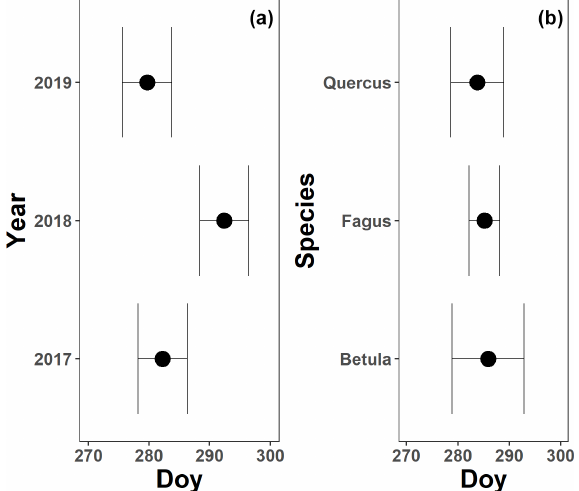
Figure A4. The mean onset of autumn leaf senescence for 3 years ( a ; 2017–2019) and the three species ( b ; Fagus sylvatica , Betula pendula and Quercus robur ) measured on all mature trees at the Klein Schietveld and Park of Brasschaat. Black dots represent the mean onset of autumn leaf senescence, while the error bars represent standard errors that indicate the inter-individual variability. All breakpoints are